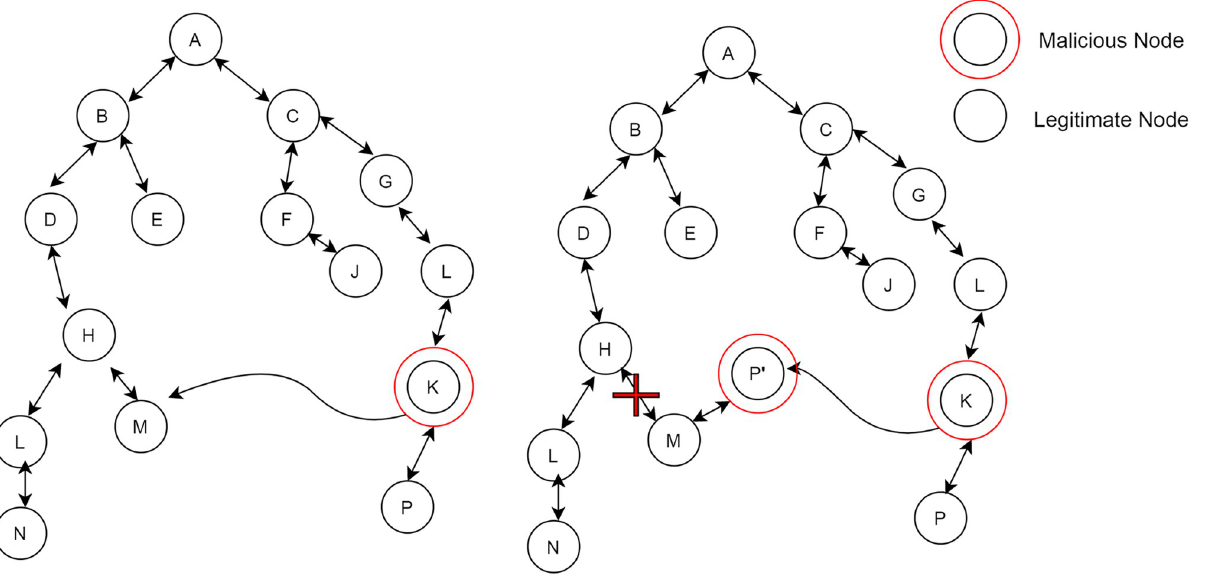
Fig 8. A Sybil attack scenario in smart healthcare